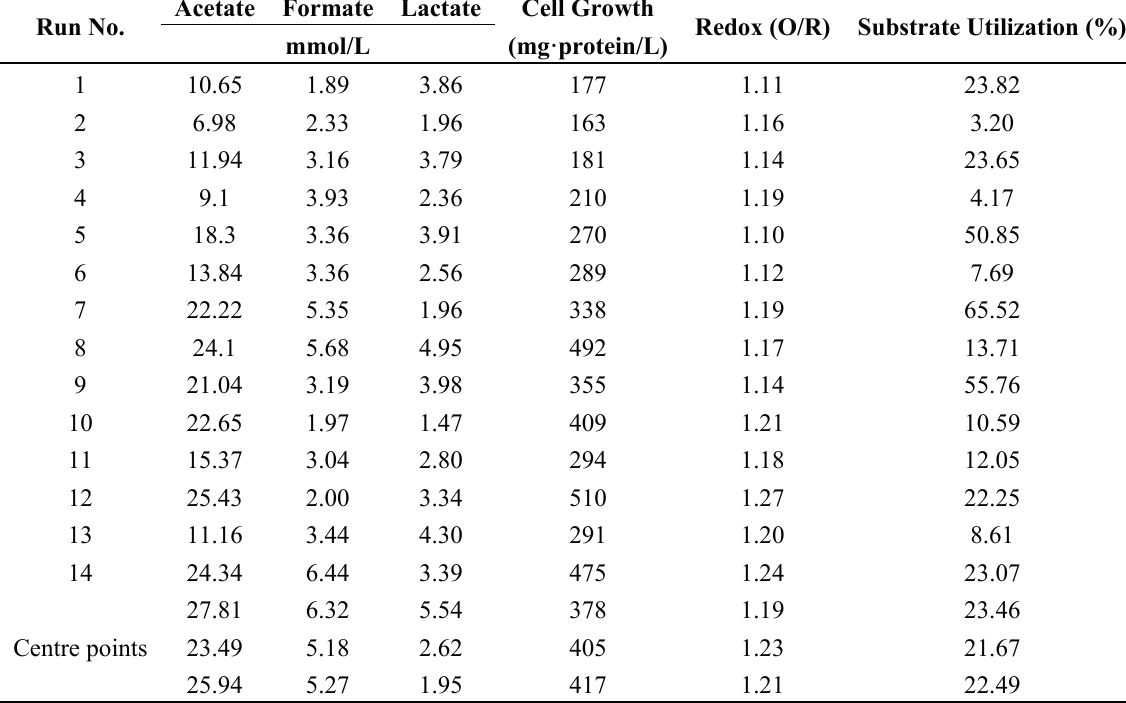
Table 2. Production of organic acids and cell-biomass by C. thermocellum DSM 1237 with corresponding redox balance and substrate converted into products. Run